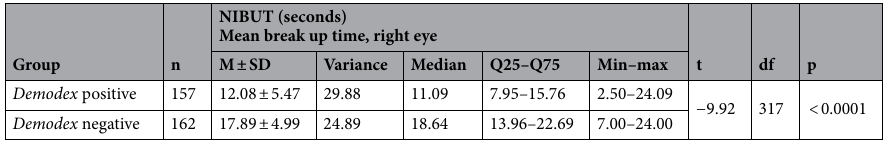
Table 5. Descriptive statistics of the mean break up time in the right eye in patients with and without Demodex infestation and results of the t-test with Cochran–Cox correction. Arithmetic mean (M), standard deviation (SD), interquantile range (Q25–Q75), degrees of freedom (df), t-value (t), p-value (p).